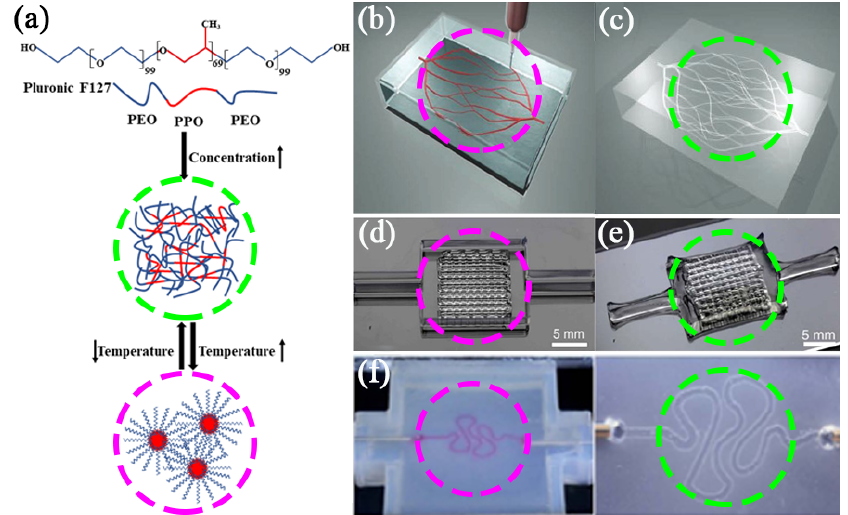
Figure 2. ( a ) Chemical structure of Pluronic F127 and the principle of temperature sensitivity. ( b ), ( c ) Pluronic F127 as a sacrificial biomaterial for printing microvascular networks (scale bar = 10 mm